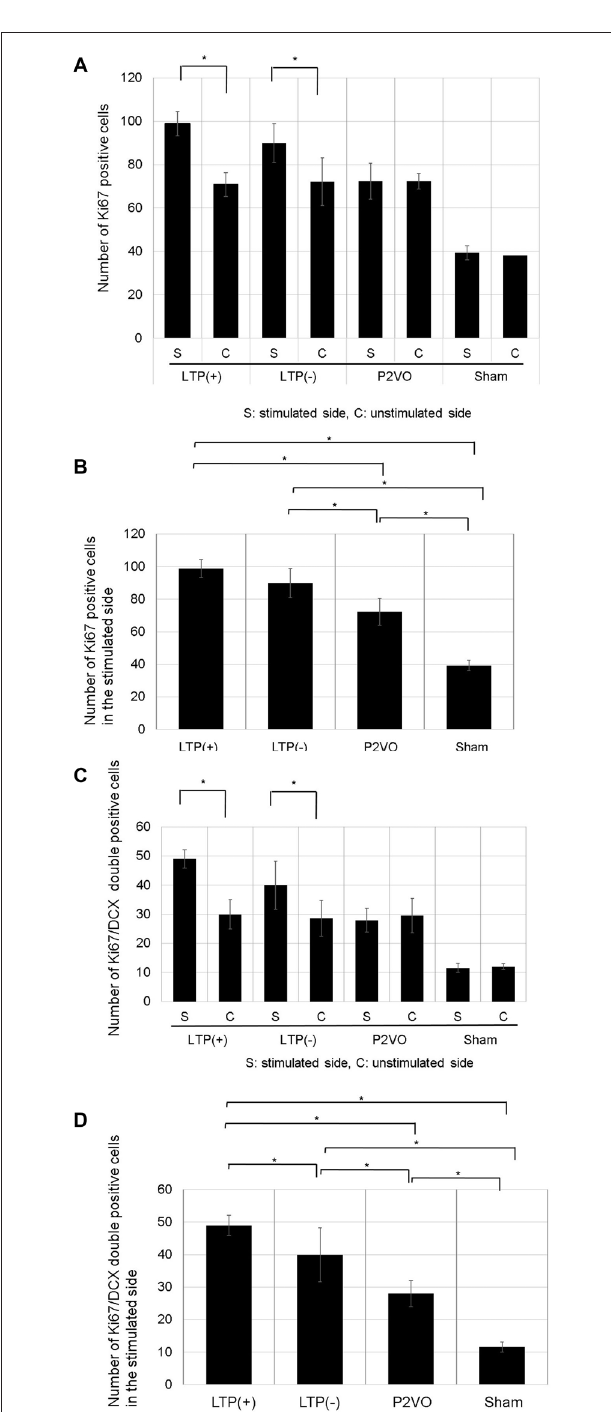
FIGURE 5 | The effect of LTP induction on precursor cell proliferation and differentiation was assessed by the number of Ki67-positive cells and Ki67/DCX double-positive cells. (A) The number of Ki67-positive cells in the DG was significantly enhanced in the stimulated hippocampi of the LTP(+) and LTP( − ) groups, relative to the unstimulated hemisphere ( N = 6, 6, 6, 3, LTP(+), LTP( − ), P2VO, sham, respectively). (B) In the stimulated hippocampi, the